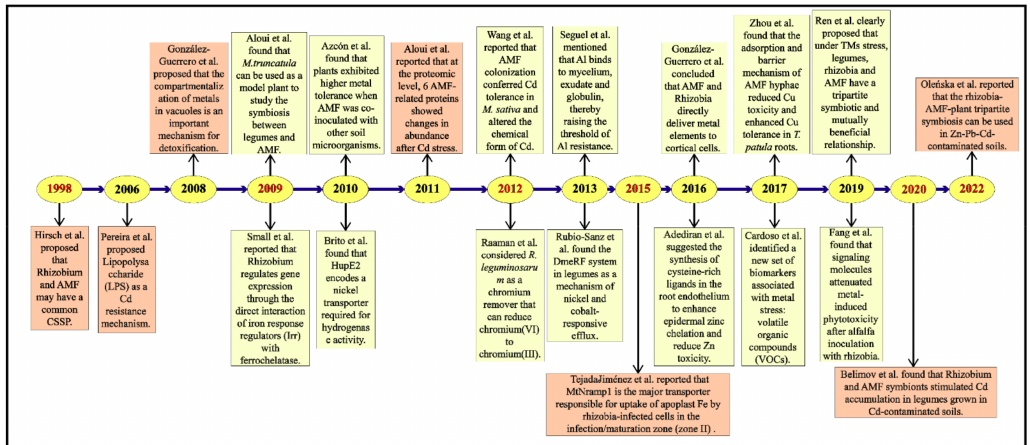
Figure 1. The research history of rhizobia and AMF over the years is summarized. The orange boxes indicate relatively groundbreaking rhizobial or AMF research findings in the field that year. The lemon-yellow boxes represent the current year’s findings of rhizobia and AMF research in this area. Publication time of some key literature on Rhizobium-plant symbiosis and AMF-plant symbiosis and the tripartite symbiosis on TM-contaminated soil of the effects. We have listed representative references of the studies included Hirsch et al. [33], Pereira et al. [34], Gonz á lez-Guerrero et al. [35], Aloui et al. [17], Small et al. [36], Azc ó n et al. [37], Brito et al. [38], Aloui et al. [39], Wang et al. [40], Raaman et al. [41], Seguel et al. [42], Rubio-Sanz et al. [43], Tejada-Jim é nez et al. [44], Gonz á lez- Guerrero et al. [45], Adediran et al. [46], Zhou et al. [47], Cardoso et al. [48], Ren et al. [49], Fang et al. [50], Belimov et al. [51], Ole´nska et al.